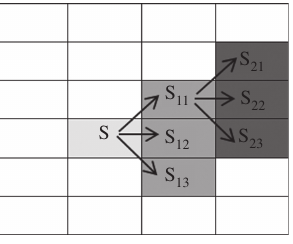
Figure 2. Pictorial Illustration of Water Flow Technique.